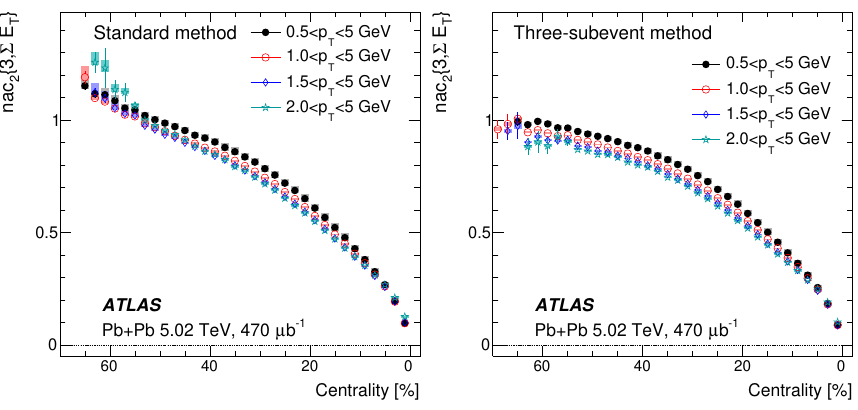
Figure 12 . The centrality dependence of nac 2 f 3 g calculated for charged particles in four p T ranges with the standard method (left panel) and three-subevent method (right panel). The error bars and shaded boxes represent the statistical and systematic uncertainties, respectively. Zero is indicated by a dotted